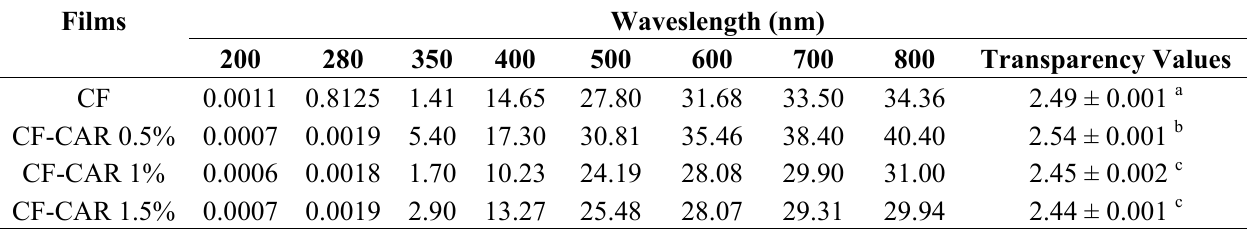
Table 3. Light transmittance (%) and transparency values of CF and CF-CAR